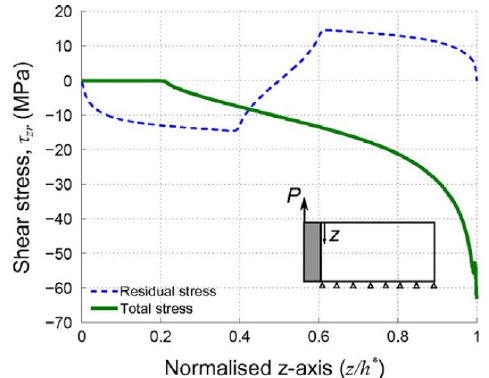
Figure 17. Shear stress distribution along the z-Pin / laminate interface (CFRP z-Pin, d = 0.51 mm, F igure 17. Shear stress distribution along [0] pre-preg, t = 4 mm)